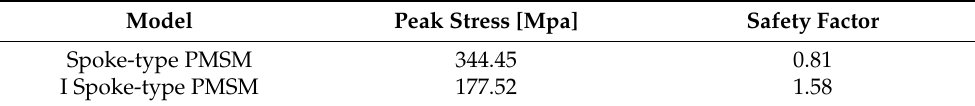
Table 8. Stiffness analysis